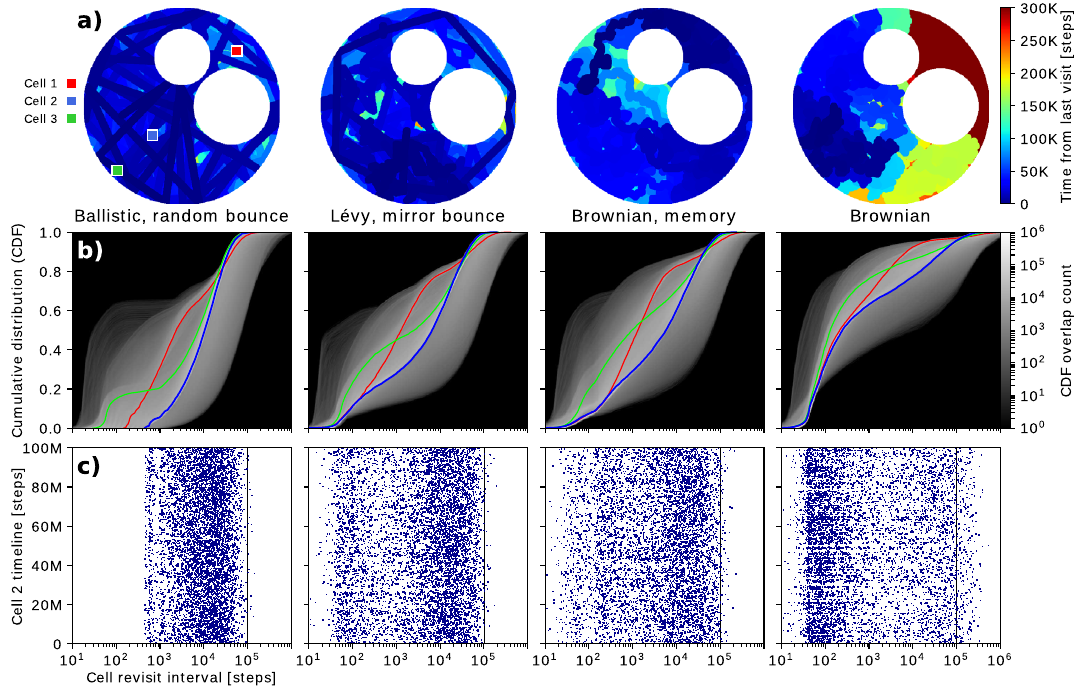
Figure 6. Revisit time analysis. For illustrative purposes we focus our analysis on the Craters map and four search strategies that have different exploration diffusivity levels (see Fig. 4). ( a ) A colour map representation of the time since last visit to each cell at step number 300K. An animated version of this representation (Supplementary Video 2) is also provided. Note the non-uniformity of the Brownian strategy in this representation. Markers 1, 2 and 3 indicate the location of three representative cells which are discussed below. The revisit sequence was also stored for every cell during a 100M step simulation for each strategy. ( b ) Cumulative distribution function (CDF) of the revisit intervals for every cell. There are three overlayed traces corresponding to the CDF for cells 1, 2 and 3. The ballistic strategy shows significantly increased redundancy near the search area limits (cell 3). ( c ) Revisit sequence for cell 2 on a plot where each data point is the revisit interval annotated at the corresponding simulation time step. The heterogeneous revisiting time of the Brownian 5 strategy becomes apparent as it is the only strategy with revisit times > 10 (indicated by a vertical line) which translate into empty horizontal stripes. This effect can be overcome with the implementation of a short-term memory to reduce local repetitions (“Brownian, memory”), which yields similar temporal profile to the Lévy- 3 mirror bounce strategy for this map. The ballistic strategy yields medium revisit times concentrated between 10 5 and 10